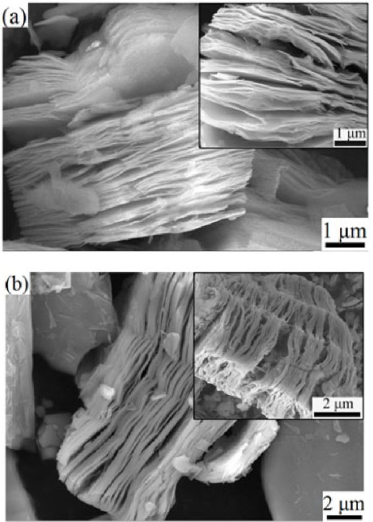
Fig. 2 SEM images of (a) Ti 3 C 2 T x and (b) V 2 CT x . The insets are int-Ti 3 C 2 T x and int-V 2 CT x , respectively.